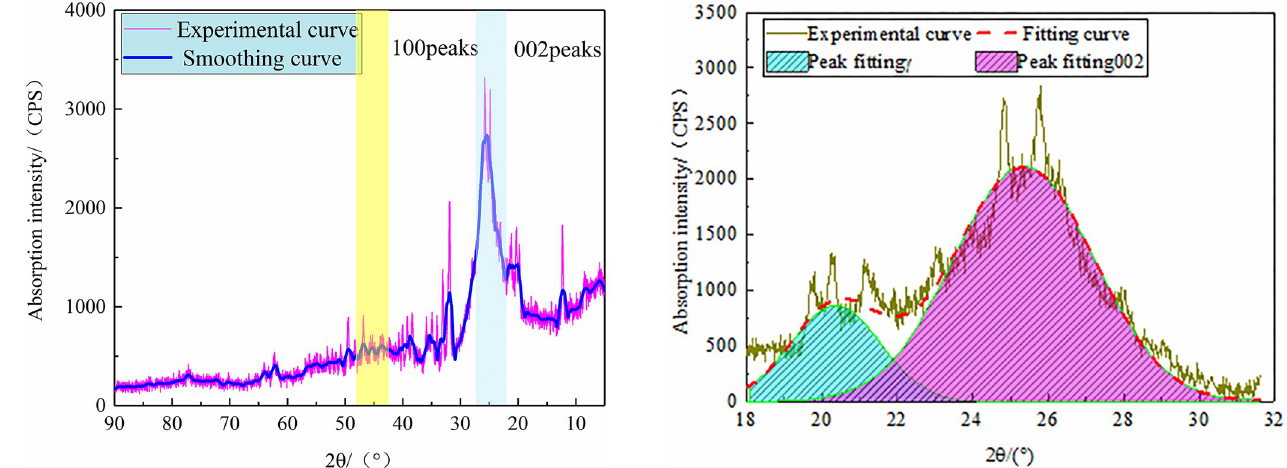
Fig 8. XRD spectrogram. (a) X-ray diffractogram of the anthracite coal sample, (b) XRD-002 Peak Fitting Map of Anthracite.